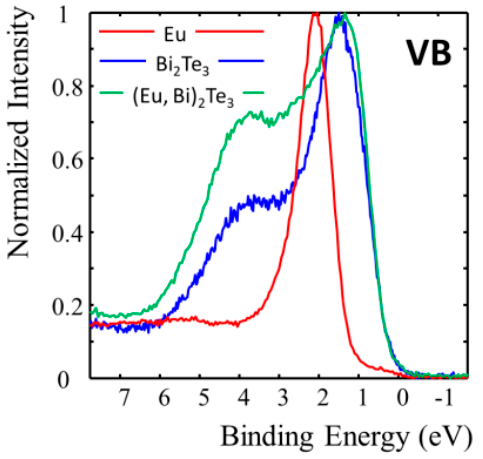
Figure 3. Valence band region for the pure europium (red line), 15nm thick Bi 2 Te 3 (blue line) and Eu doped Bi 2 Te 3 (green line) film.